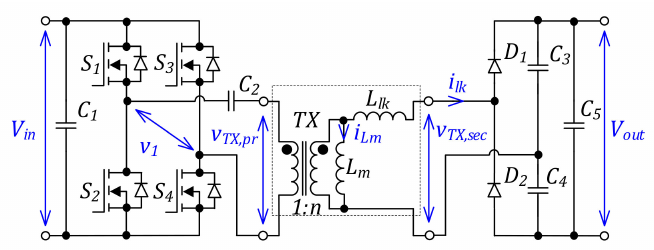
Figure 1. Case study series resonant converter.